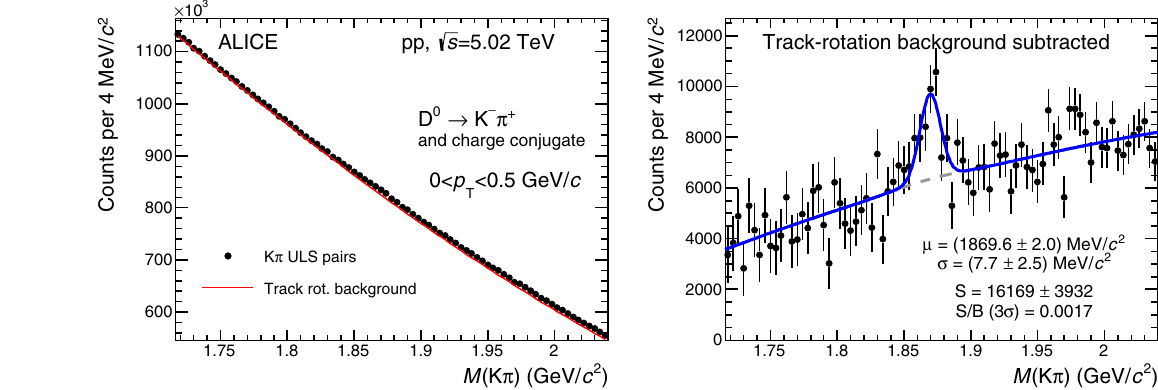
mass distributions after subtraction of the background from the track- rotation technique. The blue solid line shows the total fit function as described in the text and the grey dashed line is the residual back- ground after the subtraction of the background from the